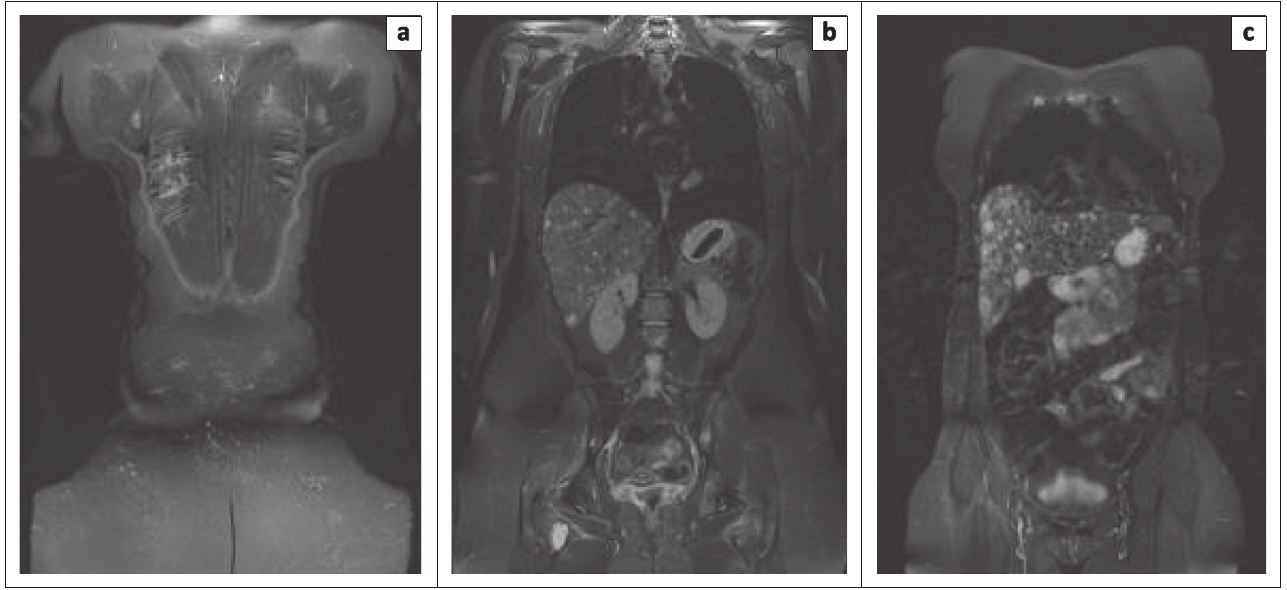
FIGURE 8: T2-weighted coronal sequence images (a, b and c) demonstrating rib lesions, hepatic angiomas and new skeletal foci.